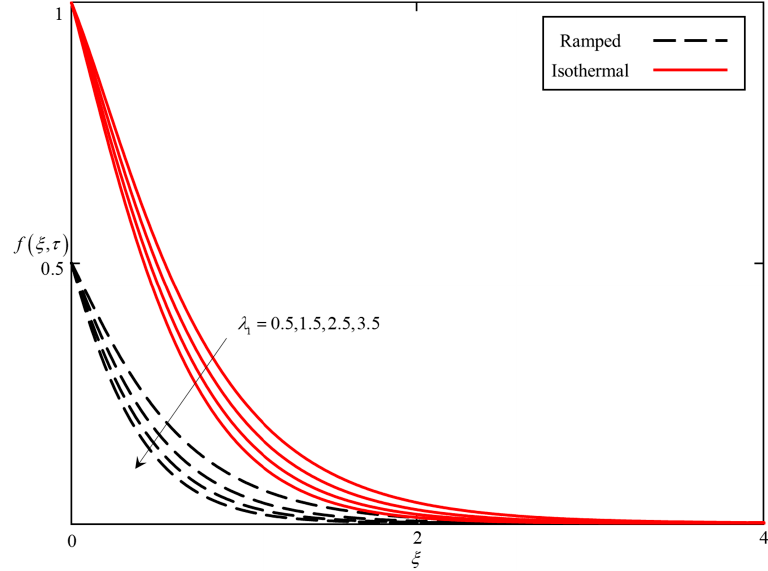
Figure 10. Consequence of λ 1 on the velocity field, when α = 0.5, β = 0.5, φ = 0.04, λ 2 = 0.5, M = 0.5, K = 0.5 Pr = 21, and Gr = 5.0.